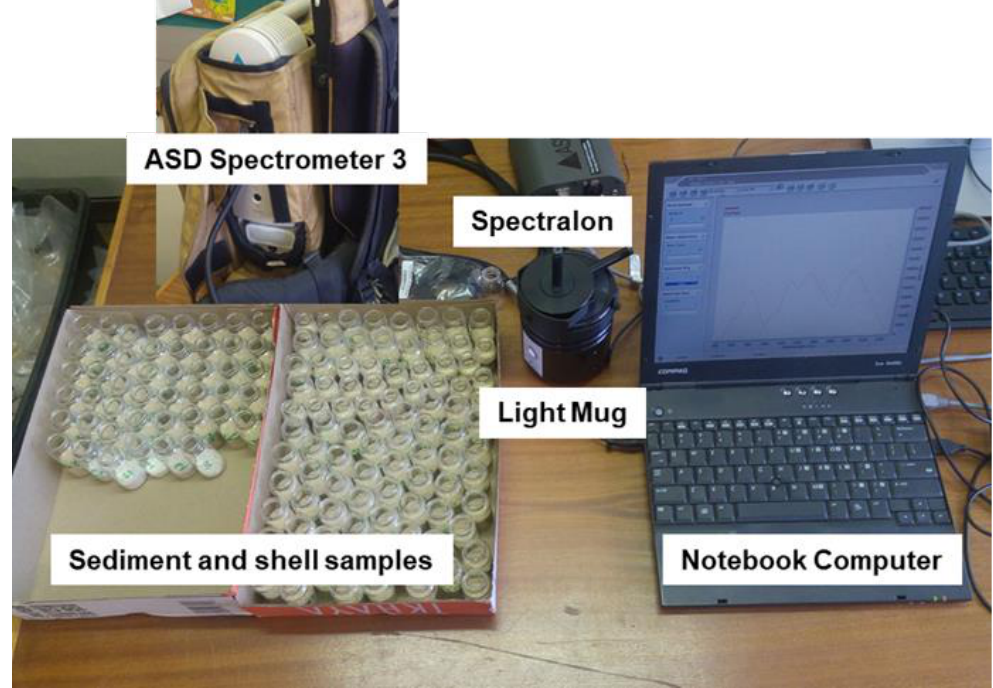
Figure 3. Laboratory spectral measurement system. The system involves an ASD spectroradiometer and a light mug device. and a light mug